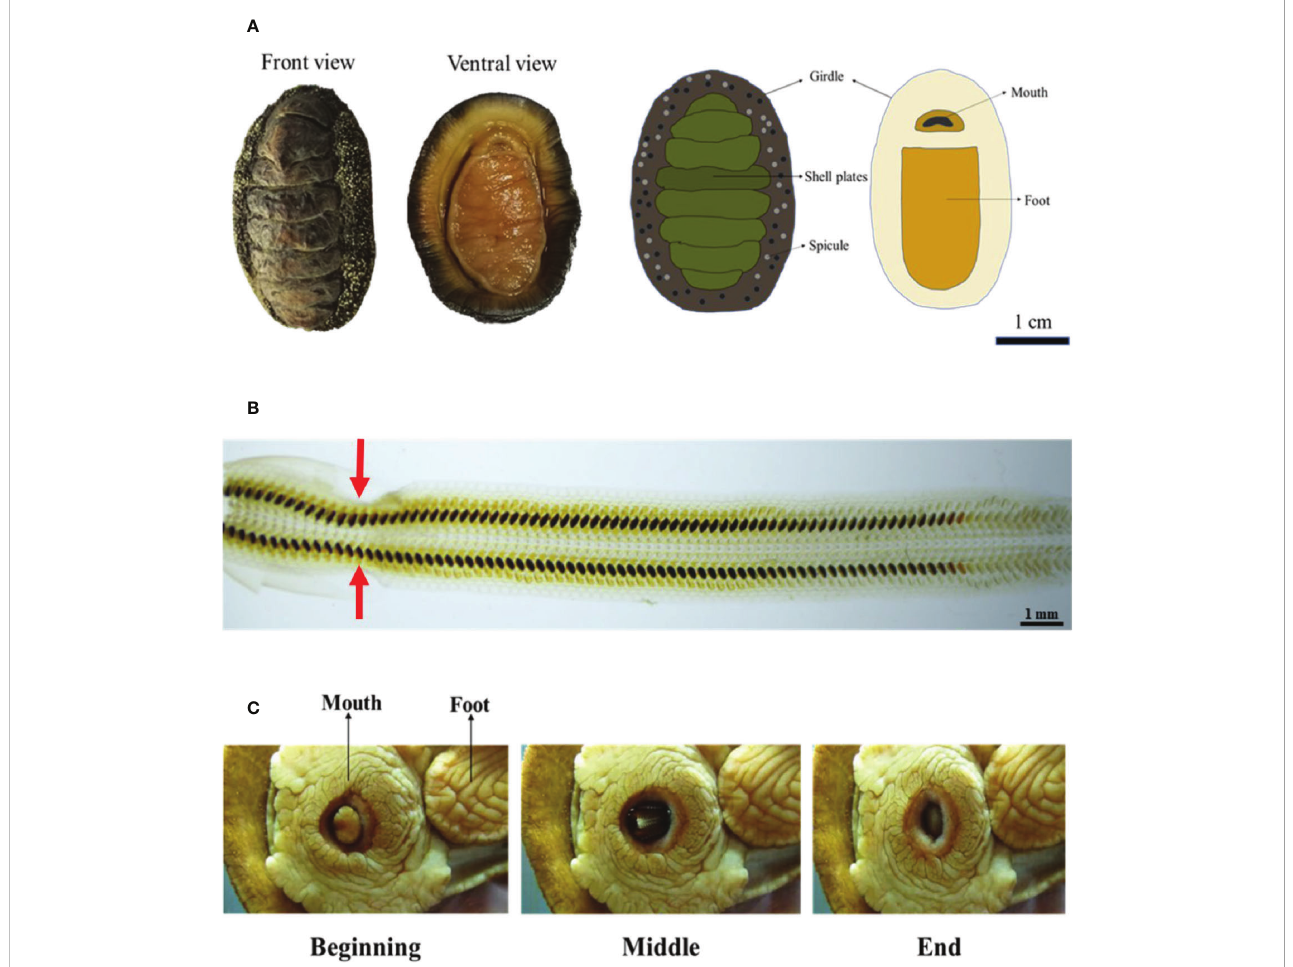
FIGURE 1 The radula and its motion in chitons. (A) Optical image and the basic anatomy of chiton Acanthopleura loochooana . (B) The radula of the chiton A. loochooana . The red arrows indicated the narrow band (C) The feeding process from chiton Cryptochiton stelleri . Images were made based on the video from https://www.youtube.com/watch?v=8JqgCXsq1OM. Image credit: VicHigh Marine/David